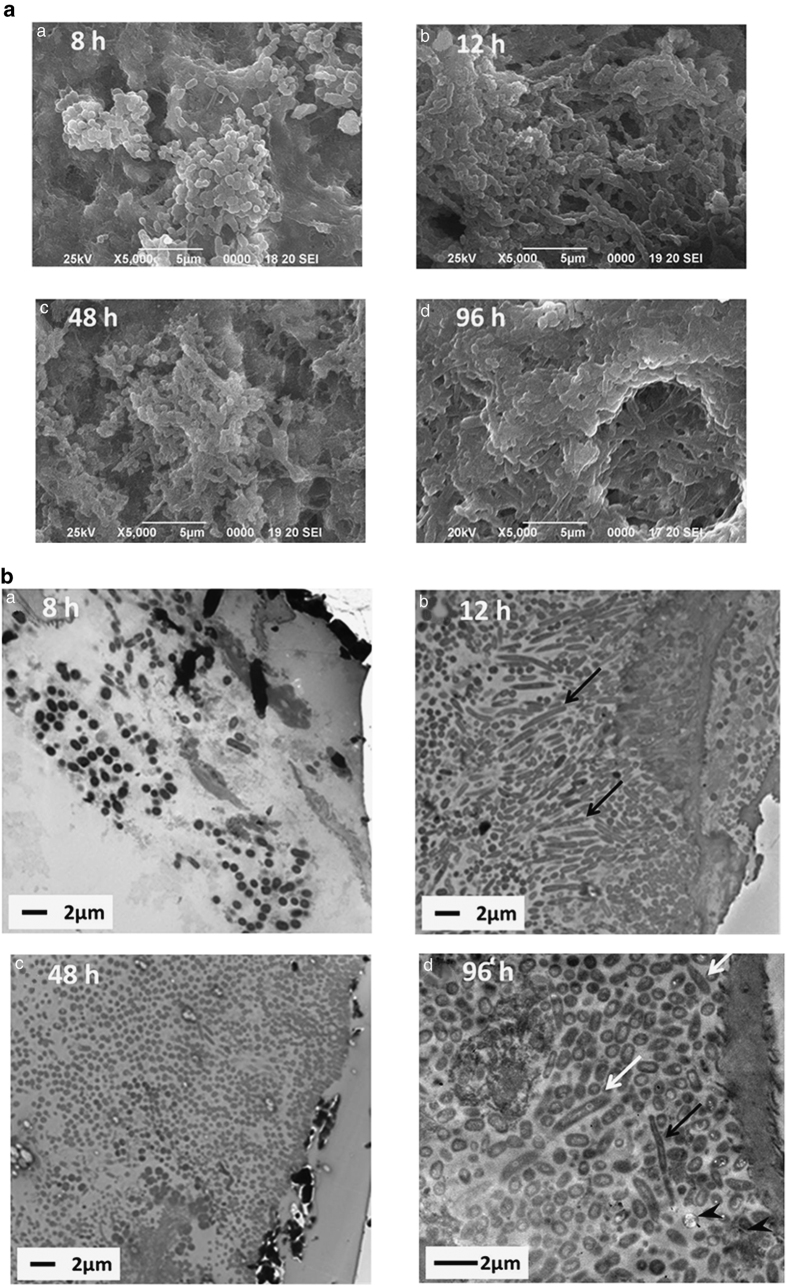
SEM and TEM observation of biofilms (a) SEM. (b) TEM. The side of the hydroxyapatite (HA) disk is shown on the right side of each image. Black arrow, filamentous bacteria; white arrow, fusiform bacteria; arrowhead, bacterial ghosts. SEM, scanning electron microscope; TEM, transmission electron microscope.